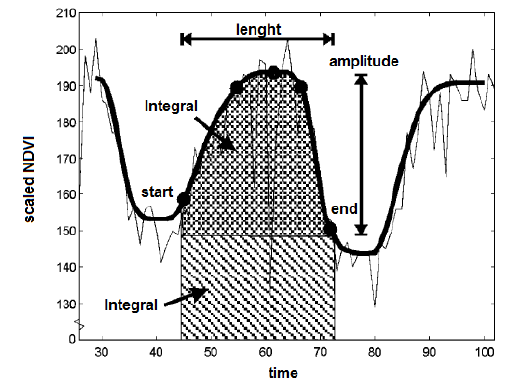
Figure 1. Seasonality parameters generated in TIMESAT (Modified from Jönsson and Eklundh, 2004)